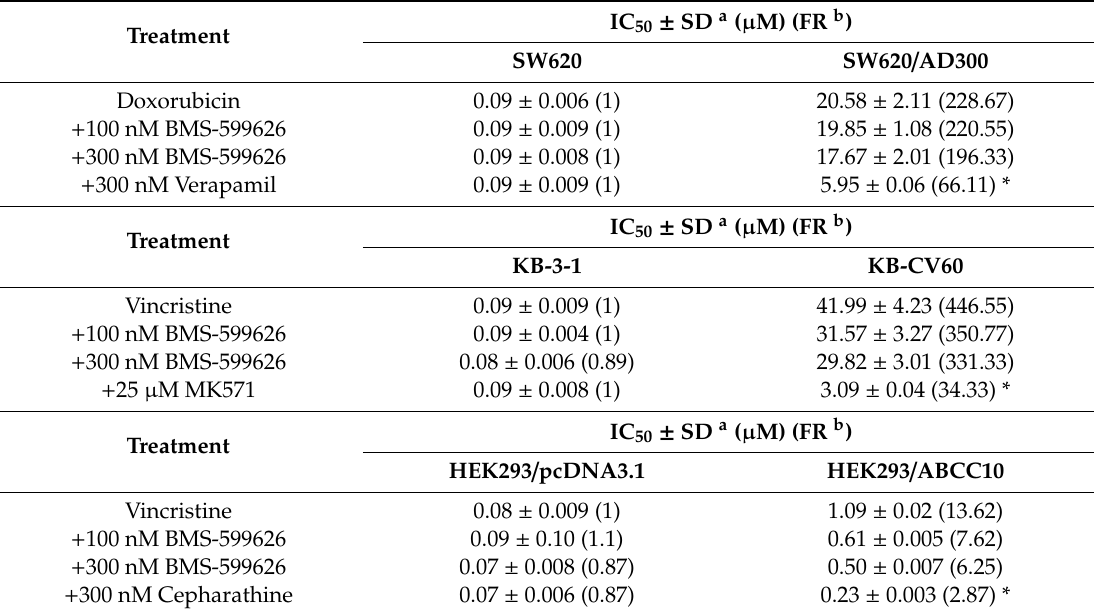
Table 1. The e ff ect of BMS-599626 on reversal of ABCB1, ABCC1, and ABCC10-mediated MDR.